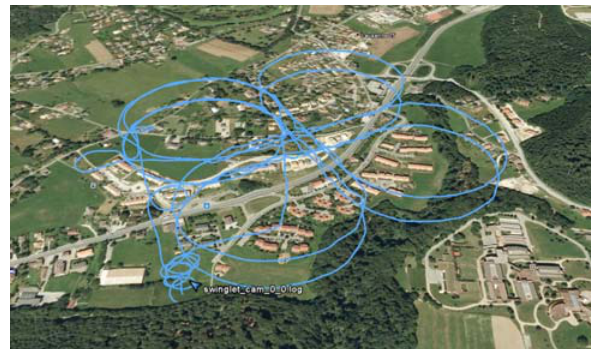
Figure 2: The trajectory of the Swinglet flight. The waves on the flight lines are due to alternative switched of the propeller, on to move, off during the camera trigger. This is done to increase stability during the image shot.